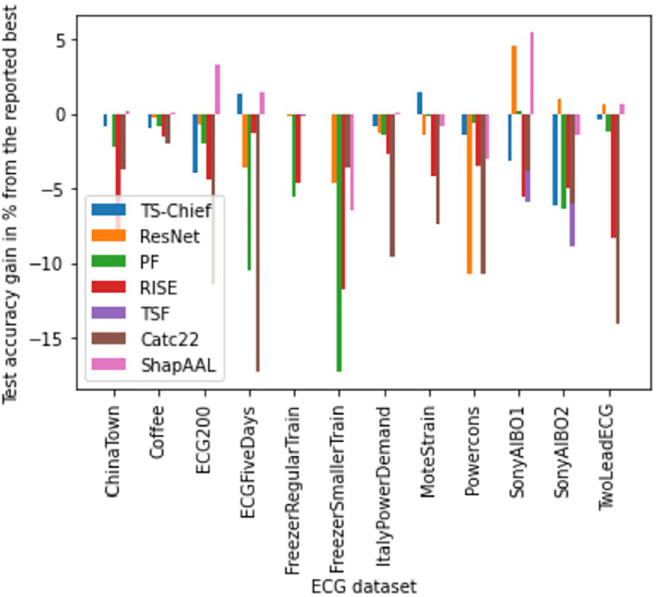
Fig 15. Differential test accuracy gain of different algorithms and proposed ShapAAL from the current reported (best) benchmark results.